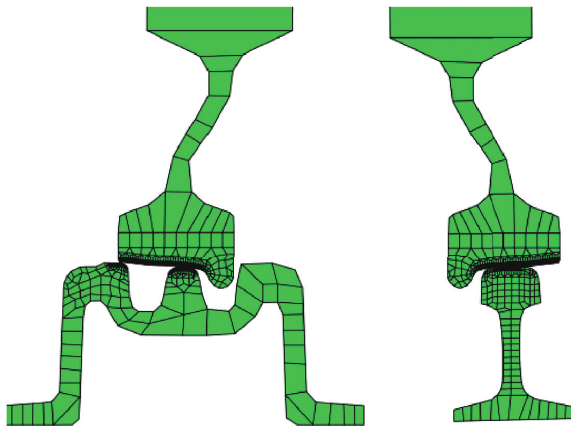
Figure 9: The two-dimensional finite elements of wheel-rail